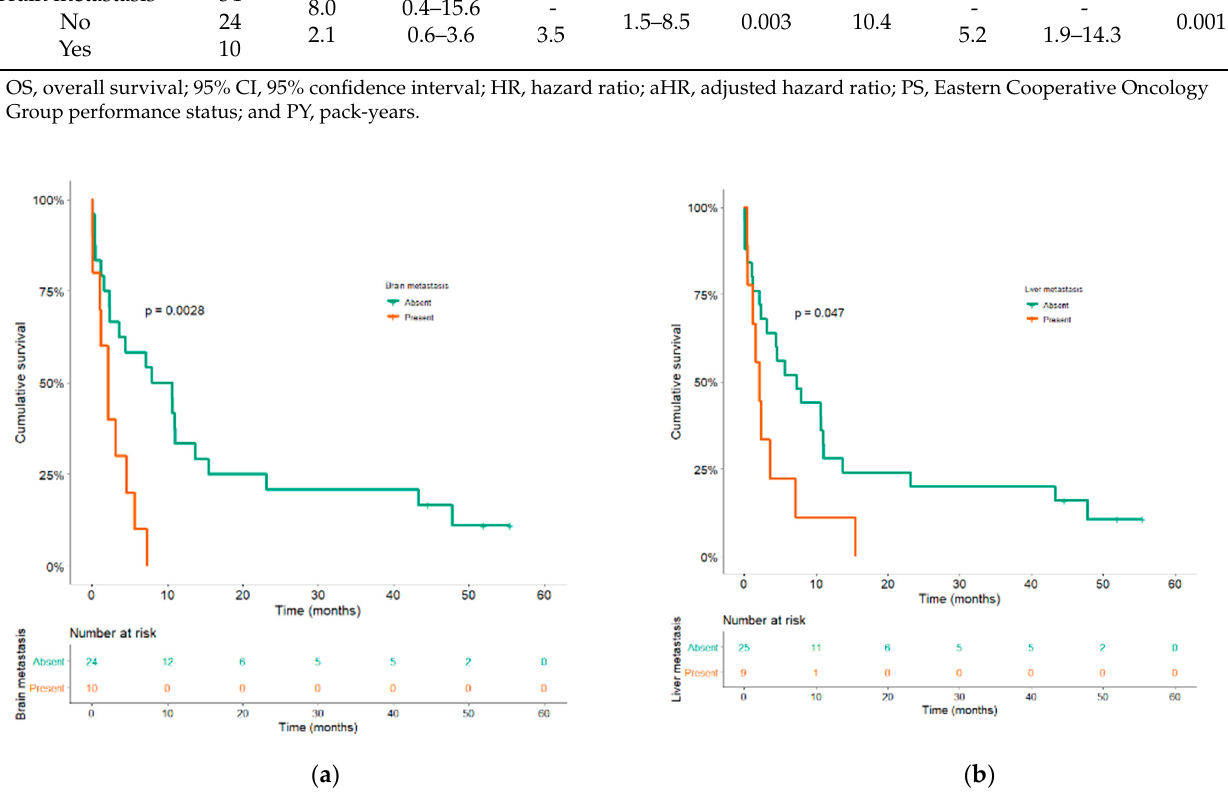
Figure 3. Kaplan–Meier curves of overall survival according to brain ( a ) and liver metastases ( b ). After adjusting for variables that demonstrated a p -value ≤ 0.1 in univariate Table 2. Univariate (Kaplan–Meier) and Multivariate Analysis (Cox proportional hazards) results. Univariate Analysis Multivariate Analysis